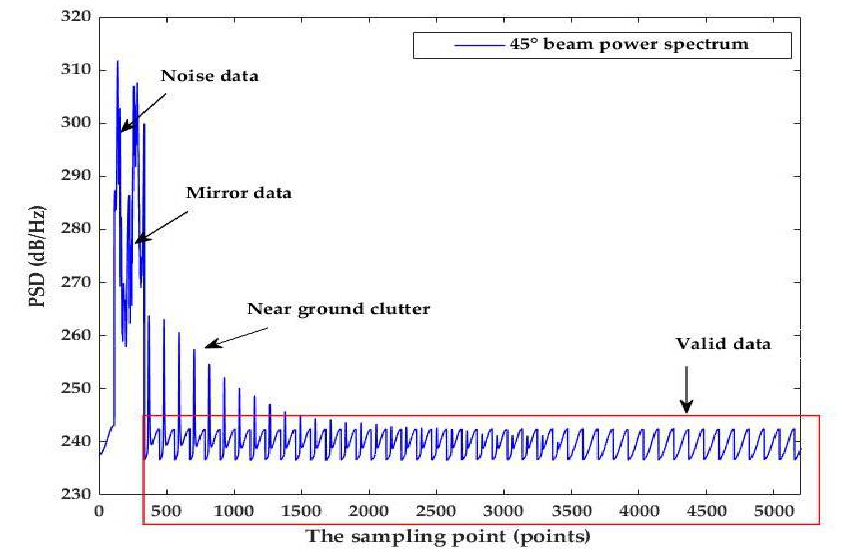
Figure 4. Power spectrum of the raw data.